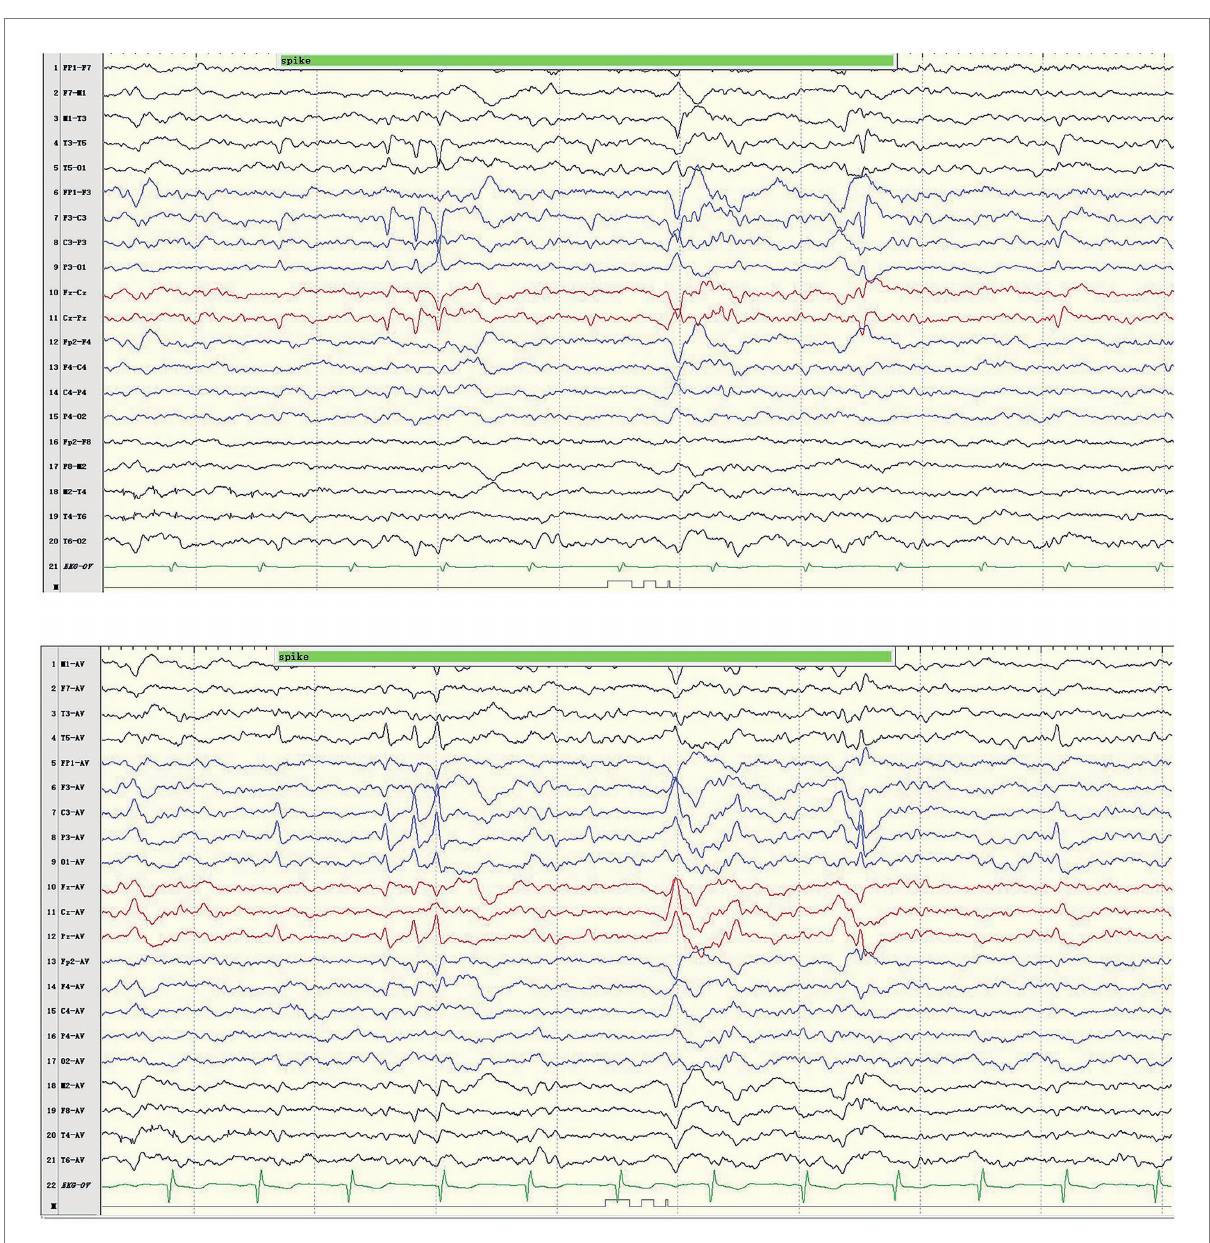
FIGURE 2 Representative EEG results of case 1. Ictal EEG recorded focal discharges in the centrotemporal area, prominently on the left